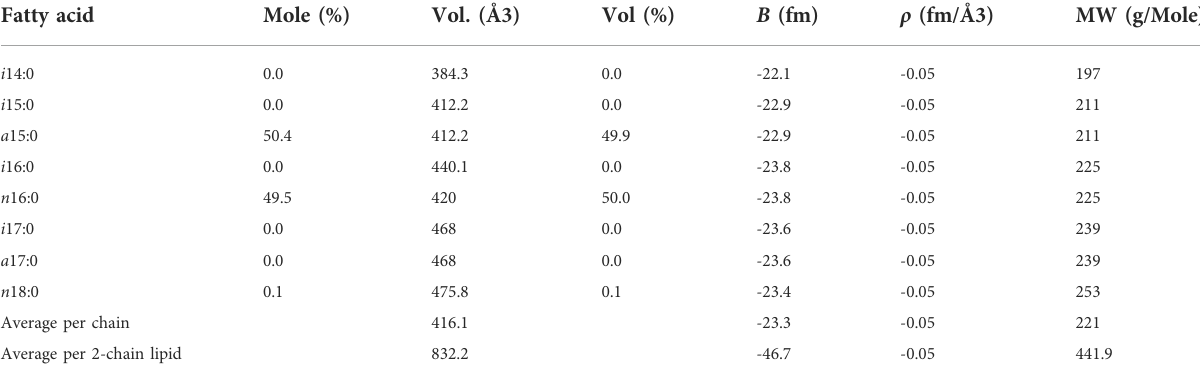
TABLE2InputparametersfortheFAcoreoflamellarmodel(Tanetal.,2021)ofcellmembranestructuretakenfromGC/MSmeasurementsandthe B. subtilis lipid extract model (Nickels et al., 2017a).